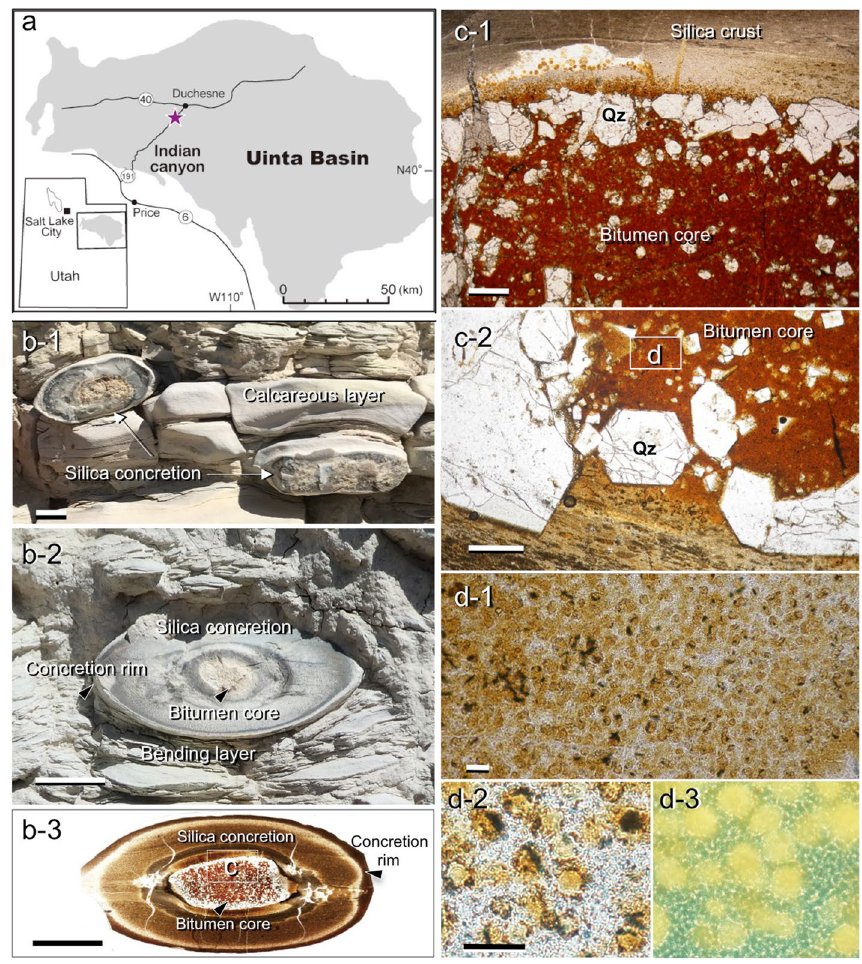
Figure 1. Occurrence of silica concretion with bitumen core. ( a ) Location map showing the sampling point in Green River Formation in the Indian Canyon section, western Unita Basin. ( b-1–2 ) Occurrence of a silica concretions and the surrounding calcareous rock showing sedimentary layers bending around a concretion, but undeflected layers preserved inside a concretion ( b-3 ). The terms used to describe parts of the concretions are also shown here ( b-2,3 ). ( c-1,2 ) Photomicrograph of a bitumen core and silica rich concretion containing euhedral quartz (Qz) crystals. ( d-1–3 ) Dense accumulation of organic microspheres in the bitumen core. Well- preserved organic spheres observed under a microscope with plane polarised light ( d-1,2 ) and by fluorescence microscopy ( d-3 ). Scale bars in ( b ) is 1 cm, ( c ) is 0.5 mm and ( d ) is 0.1 mm. All photographs shown here were taken by H. Yoshida and R.